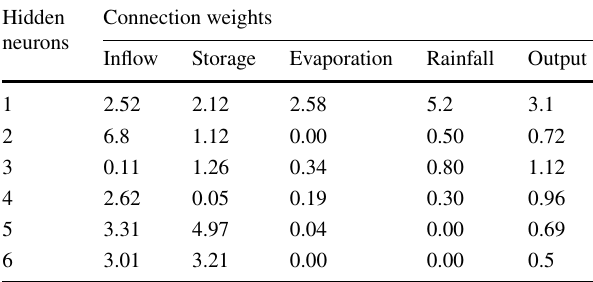
Table 4 Weighting coefficients of the ANN model Hidden